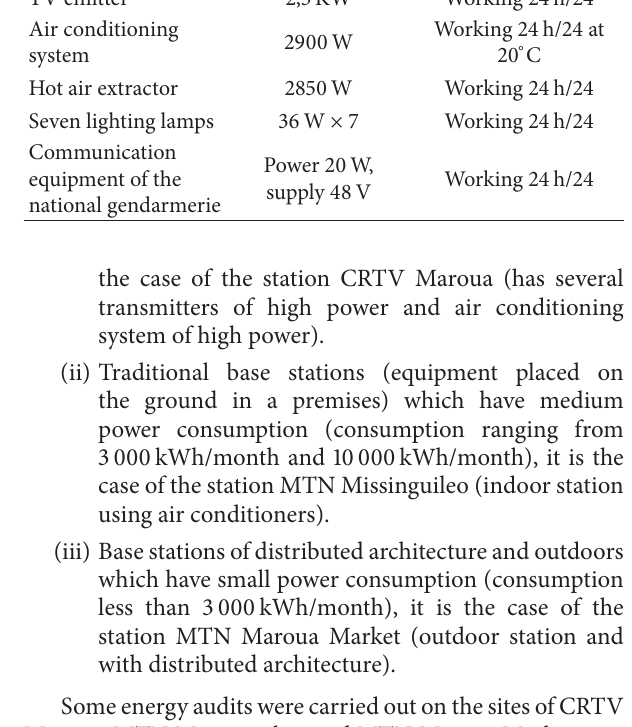
Table 1: Equipment of the TV room.